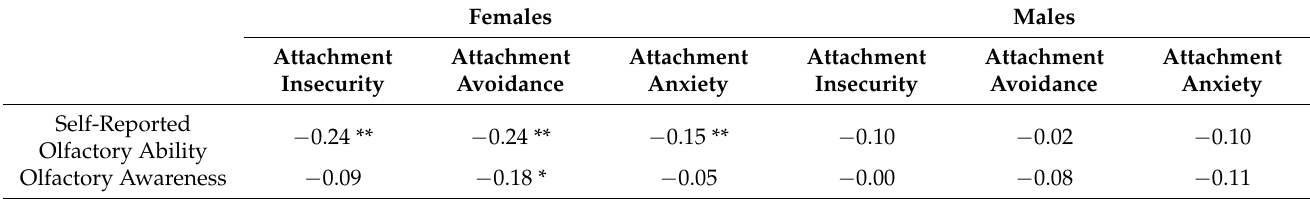
Table 2. Correlations Between Attachment and Olfactory Measures by Gender.